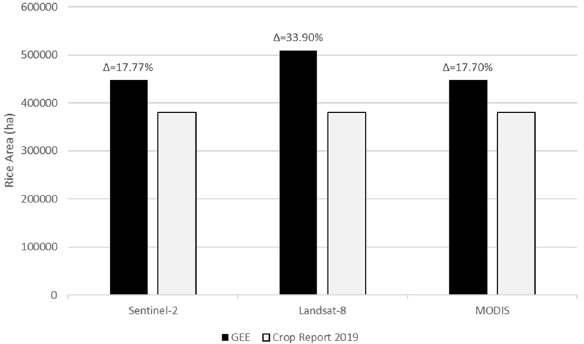
Figure 10. Comparison of rice classified cultivated area from GEE and Crop statistics report (local agrarian data). The percentage of overestimation (Δ) by GEE classification relative to ground truth data is provided for each dataset.